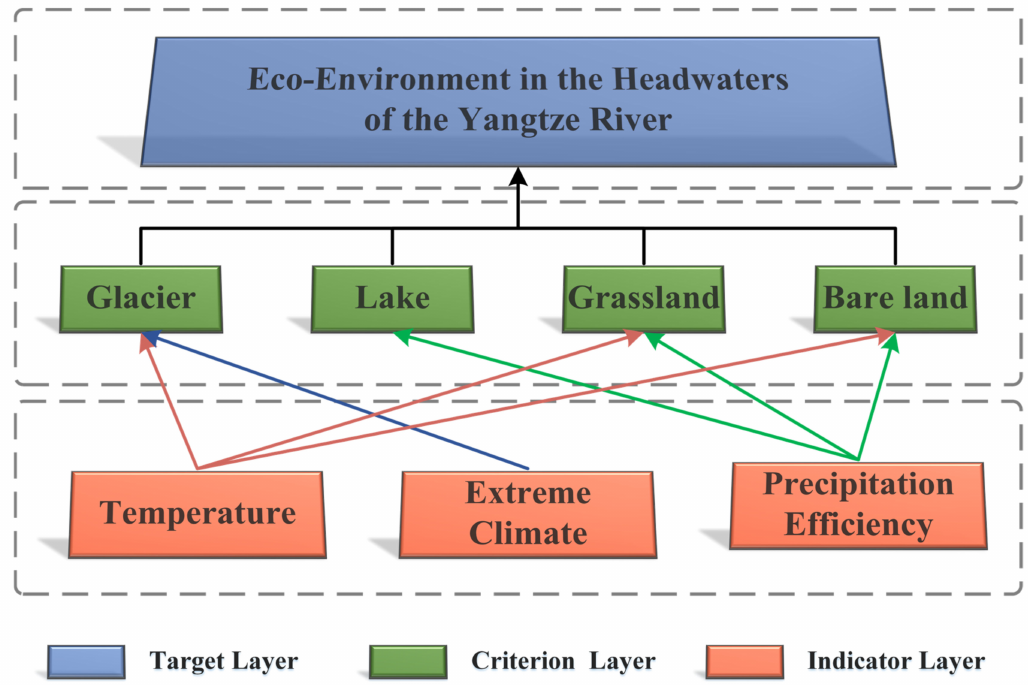
Figure 18. The systematic indicators of the headwaters of the Yangtze